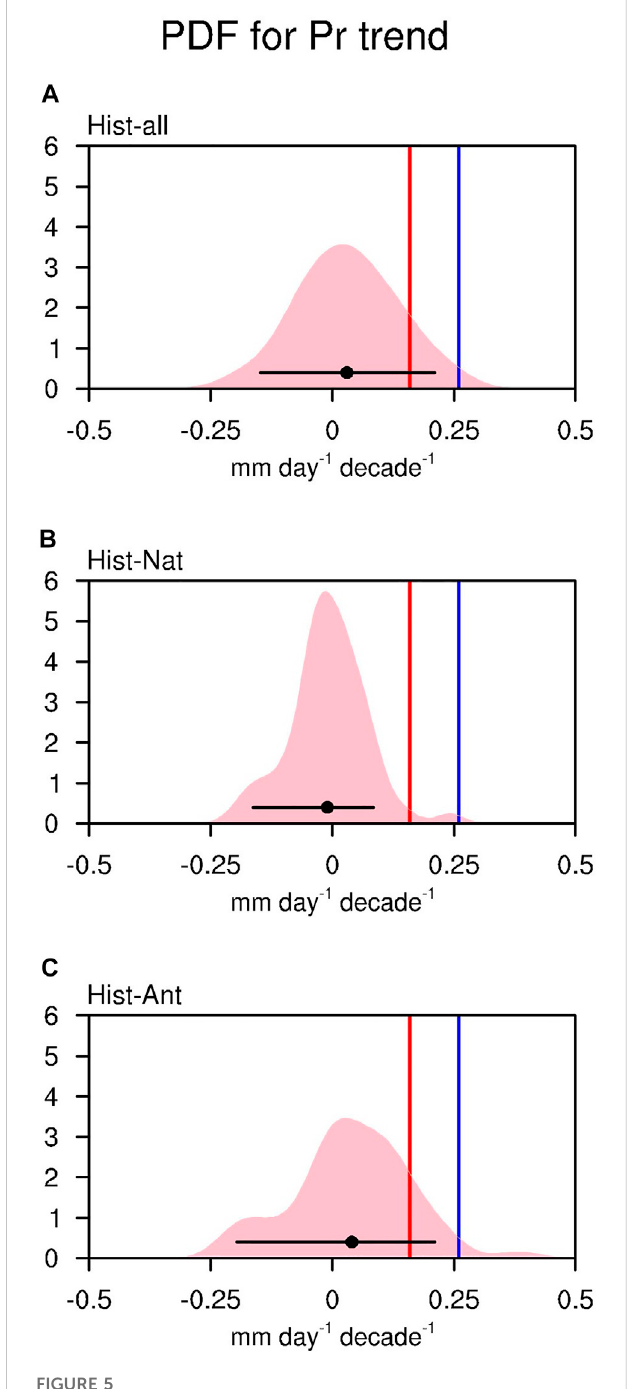
FIGURE 5 The probability density functions (PDF) of winter precipitation trends (shading, unit: mm day − 1 decade − 1 ) averaged over Southeast Asia (10 ° S – 20 ° N,90 ° – 140 ° E)derived from 58 (A) Hist-all, (B) Hist-Nat, and (C) Hist-Ant runs, respectively. The red and blue lines denote the observed trends from GPCP and CMAP, respectively. The black dots indicate the ensemble mean in each experiment, and the horizontal black lines indicate a range of 5 – 95% from the corresponding distribution. The PDFs are estimated by the